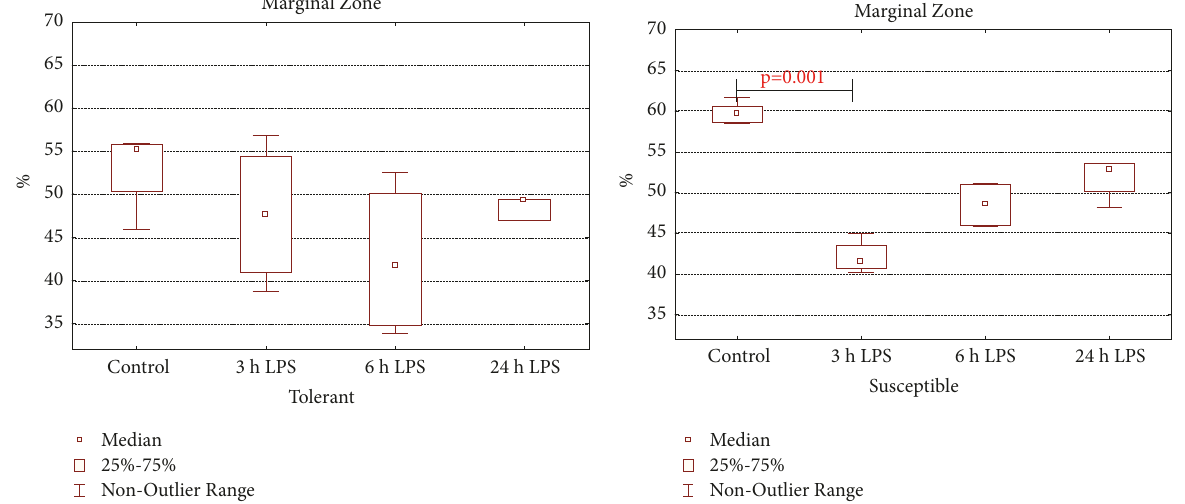
Figure 7: The volume fraction of the marginal zone of spleen lymphoid follicles in tolerant- and susceptible-to-hypoxia rats after 3, 6, and 24 hours of LPS administration. Data are presented as median (25%, 75%); the statistical significance of differences ( p ) is determined by the Kruskal-Wallis method ( 𝑛 = 5 in each